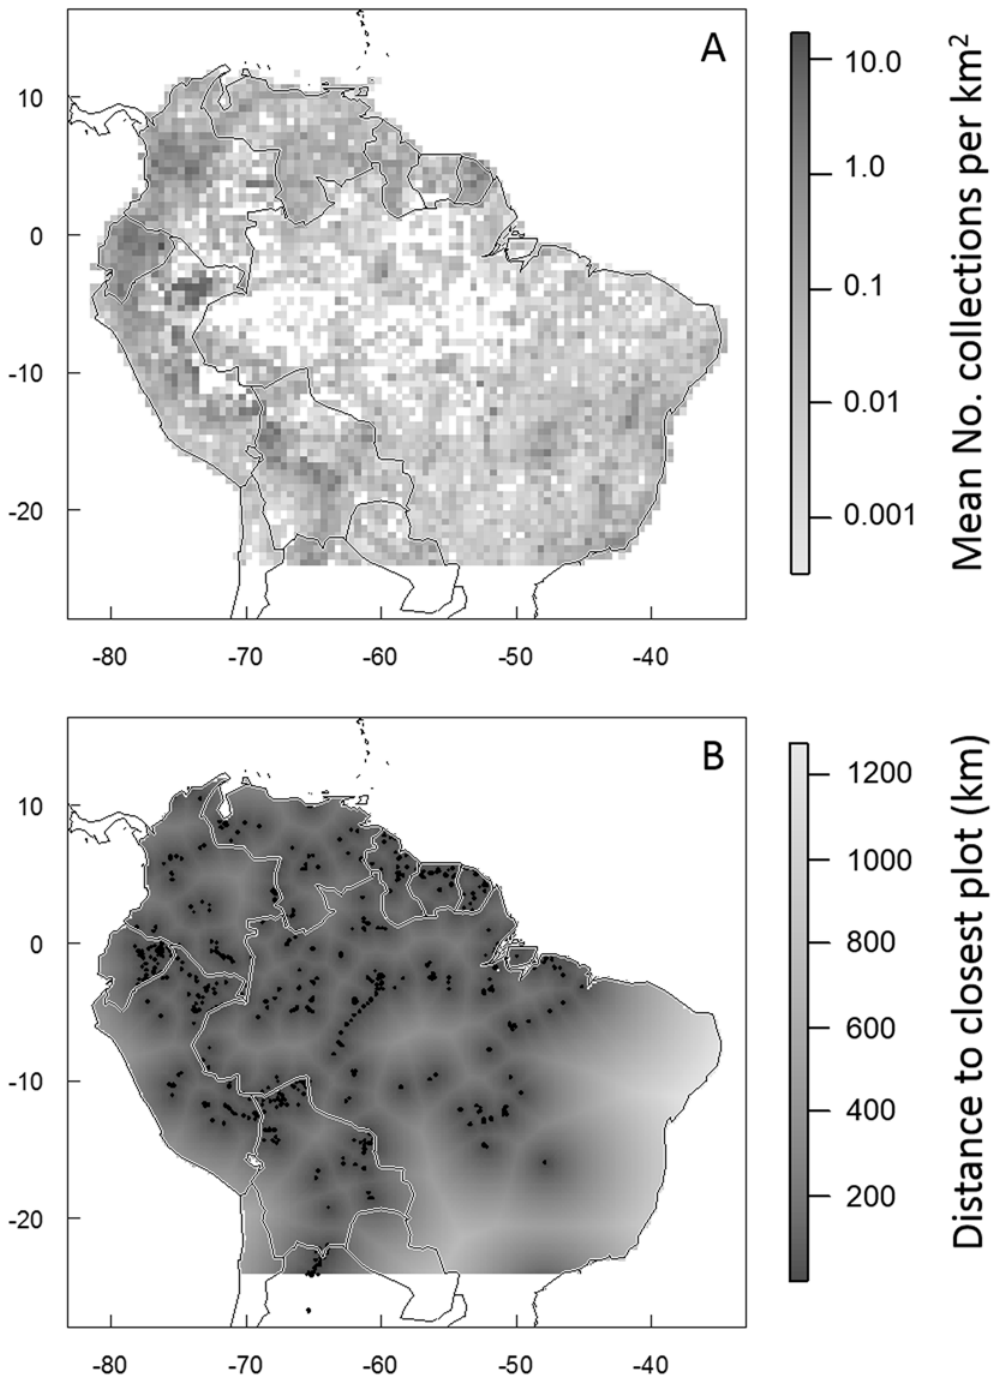
Fig 3. Density of occurrence records and distance to census plots in tropical South America. Panel A maps the mean density of plant occurrence records available in 2013 for tropical South America. Density is mapped at a spatial resolution of 0.5 x 0.5°, white pixels are areas where there are no available occurrence records. Panel B maps the distance from points in tropical South America to the closest vegetation census plot (mapped at a spatial resolution on 30 arc seconds).